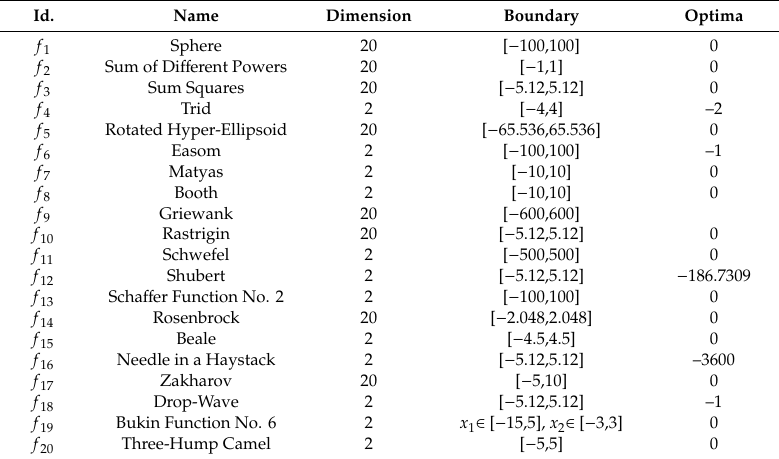
Table 3. Benchmark functions.